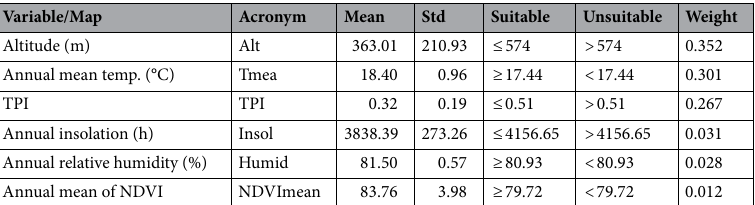
Table 1. Suitability reclassification criteria for environmental variables and weight assigned to each map, according to the percentage of contribution in PC1.